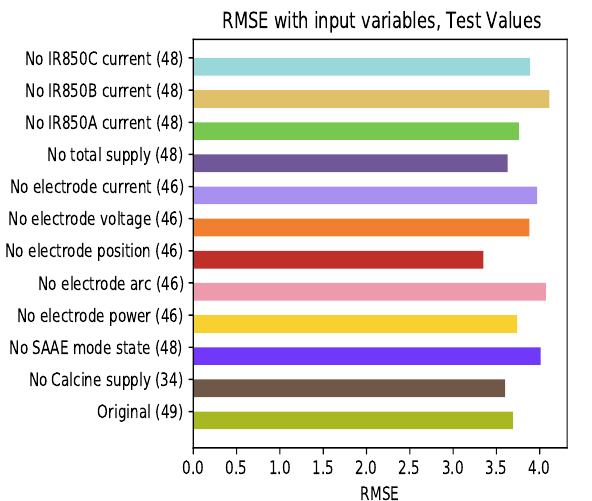
Figure 19. Average RMSE of the test set varying the learning variables at the input of the